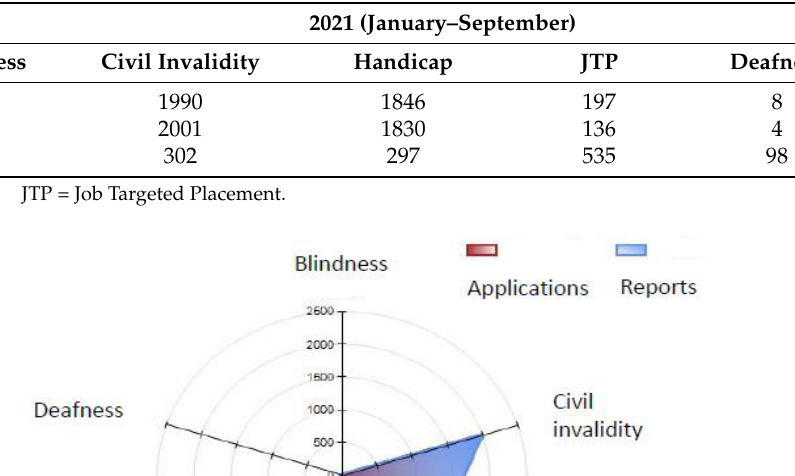
Table 3. Iglesias: distribution of ASL reports by type of application.